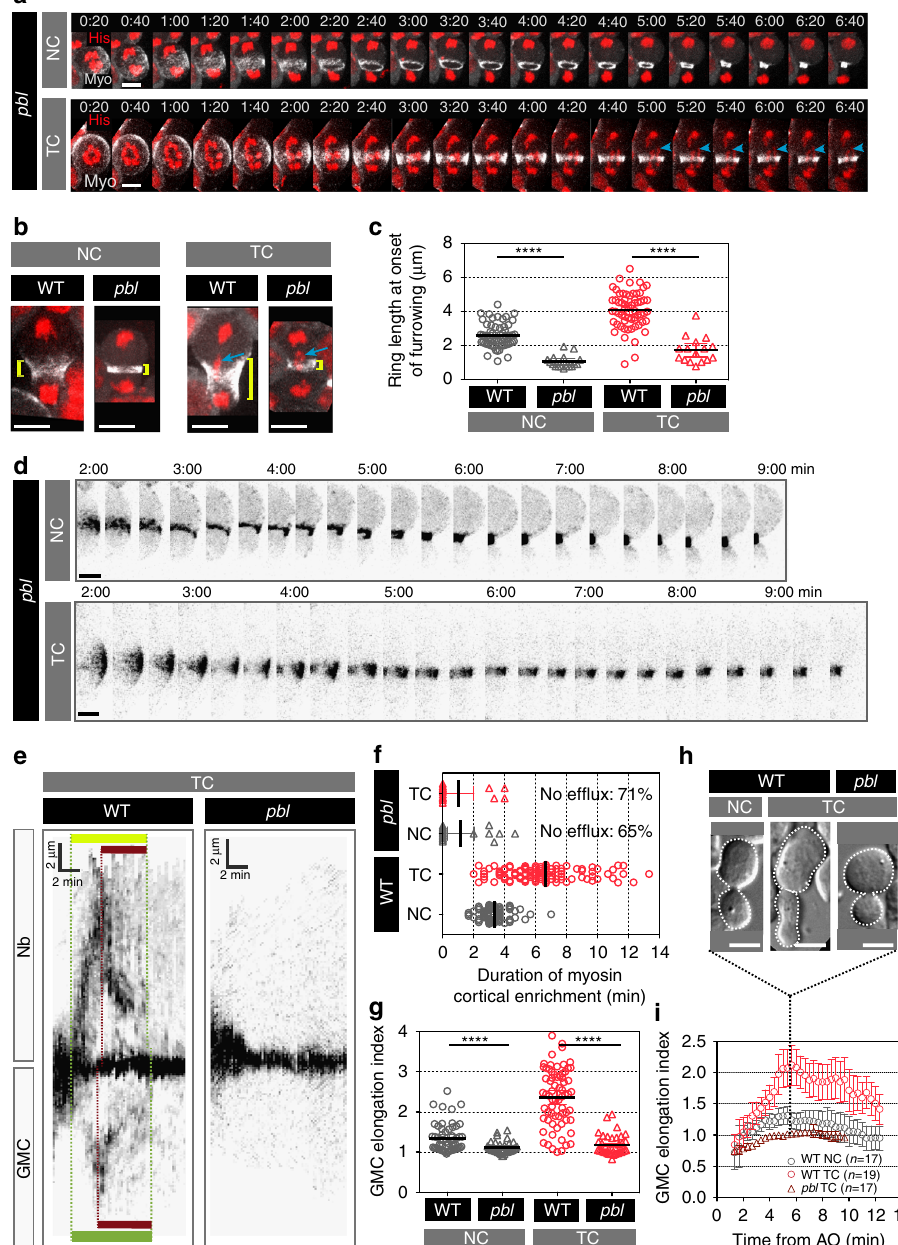
Figure 4 The RhoGEF Pebble mediates myosin ef fl ux. a Time-lapse of pebble ( pbl ) mutant cells expressing H2Az::mRFP (His, red ) and Sqh::GFP (Myo, gray ) with NC or TC. The blue arrowheads indicate trailing chromatid arms. See Supplementary Movie 3. b Images of wild type ( WT ) and pbl mutant cells with NC or TC expressing H2Az::mRFP ( red ) and Sqh::GFP (Myo, gray ) from time-lapse movies at the onset of furrowing. The length of the contractile ring is indicated with yellow brackets . The blue arrows point to TC arms . Scale bars = 5 µ m. c Scatter dot plot showing the distribution of the ring length at the onset of furrowing in WT (as shown in Fig. 1d) and pbl mutant cells with NC or TC. ( pbl NC, n = 17; pbl TC, n = 16). d Time-lapse images of pbl mutant cells with NC or TC expressing Sqh::GFP during cytokinesis. Half of the cell cortex is shown starting 2 min after anaphase onset. e Kymographs of WT or pbl mutant cells with TC showing Sqh::GFP dynamics from one pole to the other. The yellow and green horizontal bars show the duration of myosin cortical ef fl ux from initiation to disappearance in Nb and GMC, respectively. The brown bars correspond to the time of lateral myosin ring contraction. The scale bars on the x and y axes indicate 2 min and 2 µ m, respectively. f Scatter dot plot showing the duration of myosin ef fl ux in WT cells with NC or TC (as shown in Fig. 2f) and pbl mutant cells with NC or TC. No myosin ef fl ux is visible in more than 60% of pbl mutant cells regardless of the presence of trailing chromatid arms. ( pbl NC, n = 17; pbl TC, n = 14). g Scatter dot plot showing the GMC elongation index of WT with NC or TC (as shown in Fig. 2h) and pbl mutant cells with NC or TC ( pbl NC, n = 37; pbl TC, n = 38). h DIC images of WT and pbl mutant cells at 6 min after anaphase onset to illustrate the elongation of the nascent daughter cells associated with myosin ef fl ux. The white dashed lines outline the cells. i Graph showing the GMC elongation index over time in WT (as shown in Fig. 2k) and pbl mutant cells. Time 0:00 corresponds to anaphase onset (AO). Time = min:s. n = number of cells. Scale bars = 5 µ m. The mean ± 95% CI is presented for all graphs and scatter dot plots. A Mann-Whitney test was used to calculate P values (**** corresponds to P <